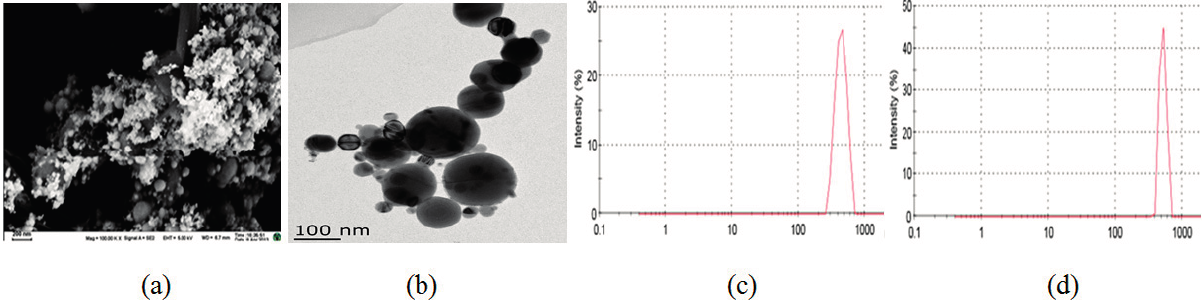
Figure 1. SEM (scale bar = 200 nm) ( a ) and TEM (scale bar = 100 nm) ( b ) images and particle size distributions of nickel nanoparticles (Ni NPs) of 5 μ g/mL ( c ) and 12.5 μ g/mL ( d